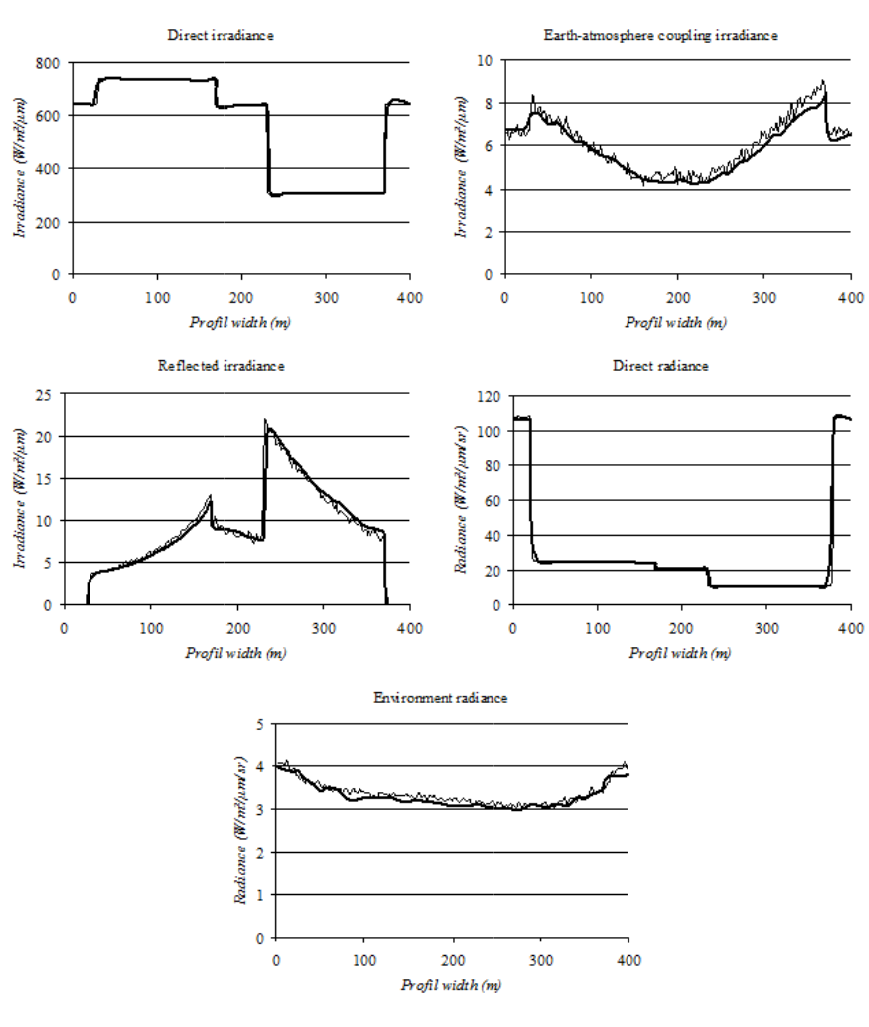
AMAR visibil it is